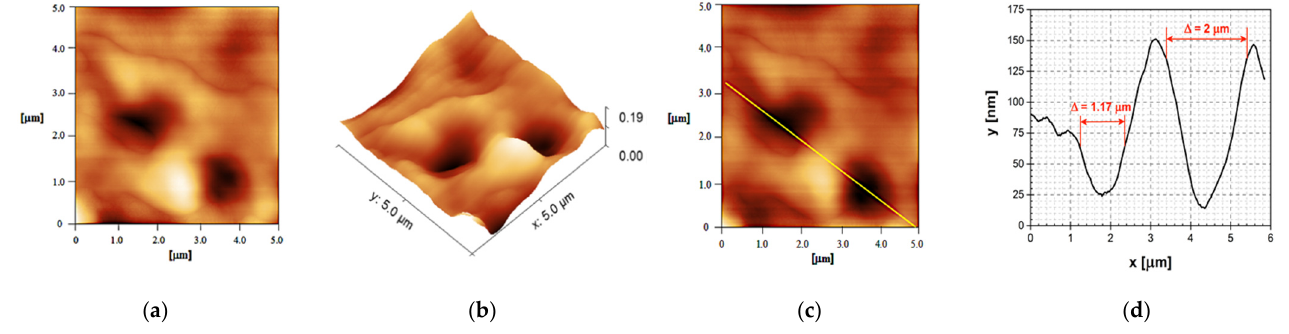
Figure 4. AFM images of the film topography obtained by scanning the 5 × 5 μ m 2 film surface of sample S2A ( a ), 2D and ( b ) 3D; ( c ) direction of the profile observed along the two inclusions (S2A); ( d ) profile along the two inclusions or valleys with the diameter of the inclusions/valleys.